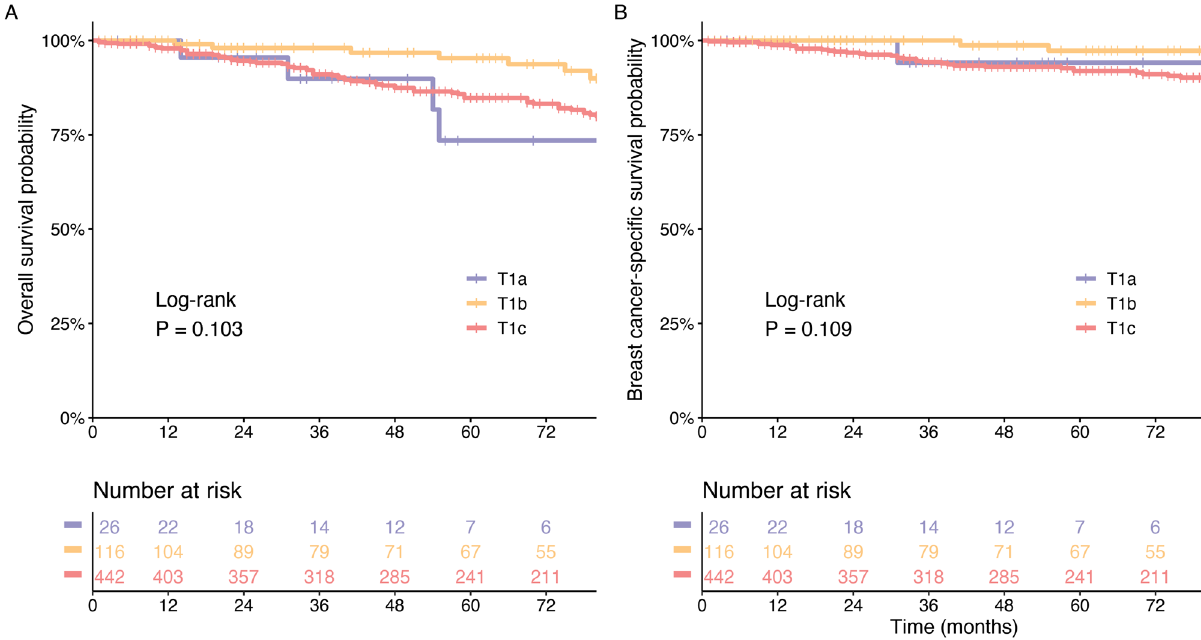
Figure 2. Kaplan–Meier curves comparing the survival of patients with MpBC stratified by T1 stage. ( A ) Overall survival; ( B ) Breast cancer-specific survival. P -value was determined by univariate log-rank